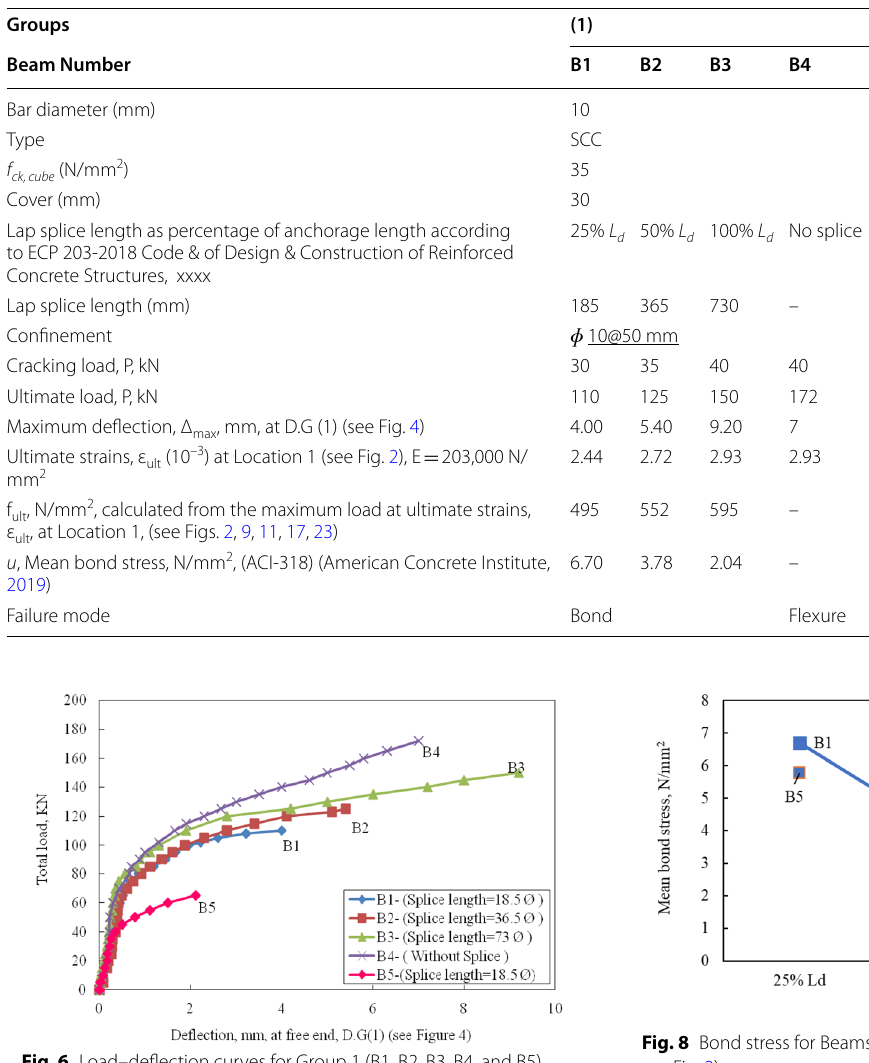
Table 4 Results of the tested beams